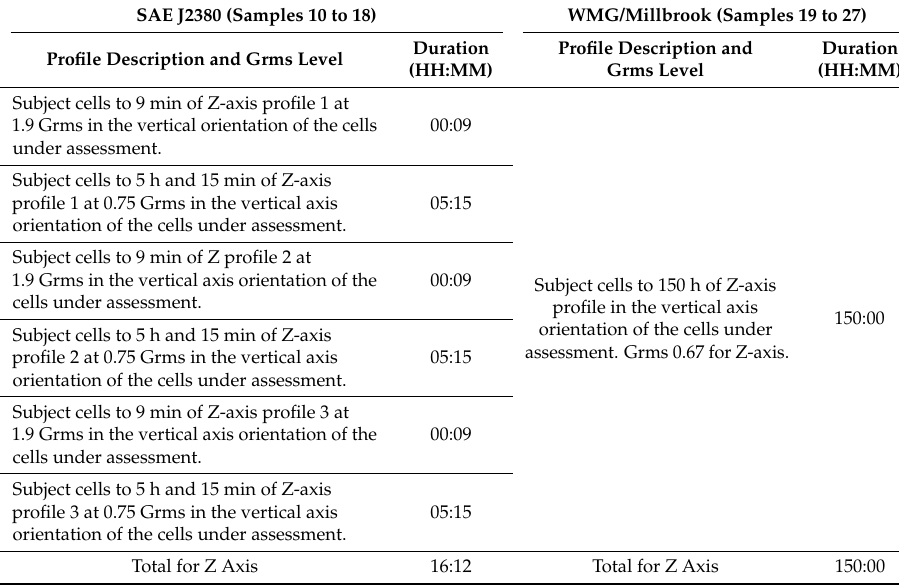
orientation of the cells under assessment. Grms 0.67 for Z-axis.